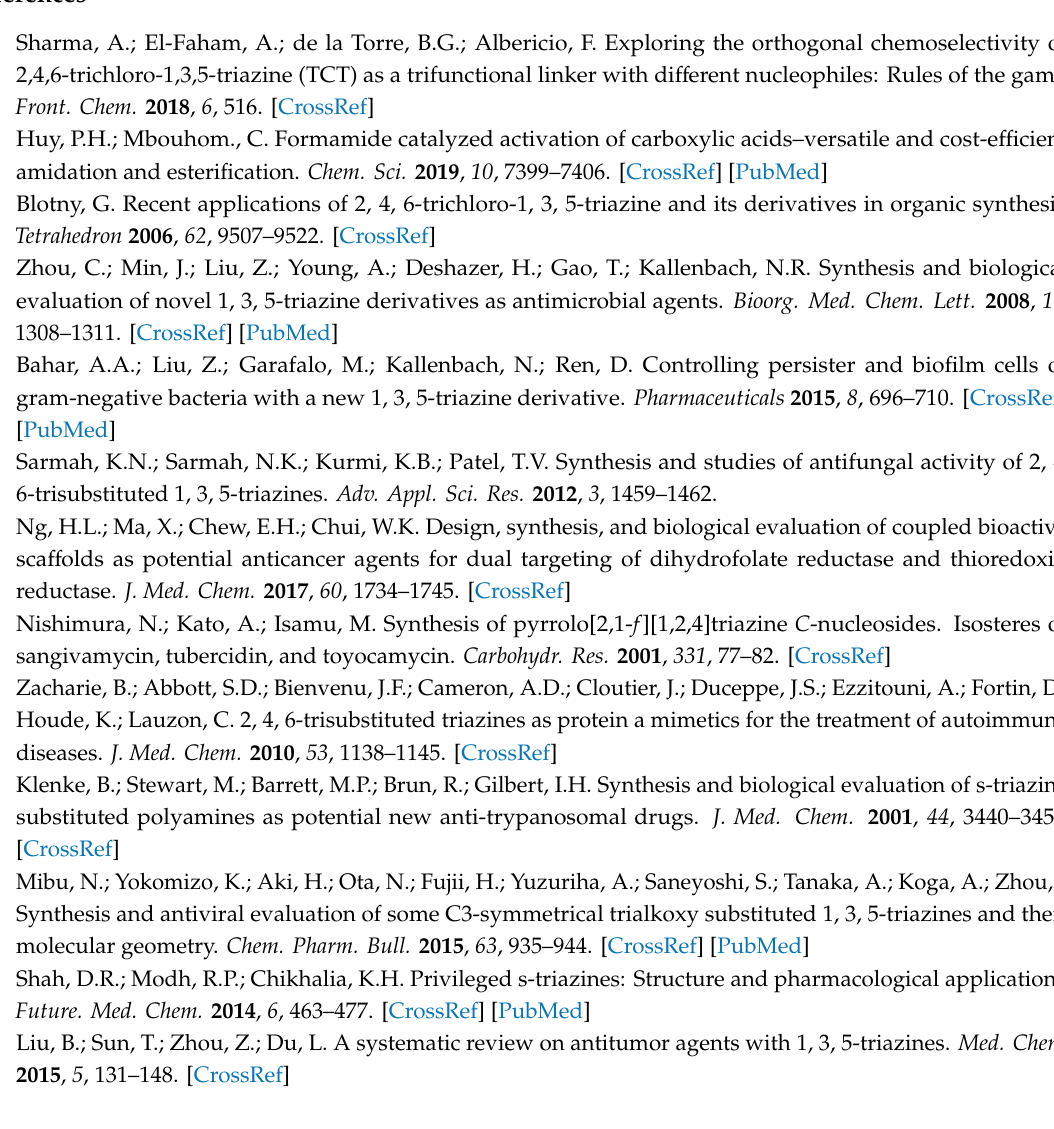
Figure S2: 1H-NMR and 13C-NMR for compound 7b, Figure S3: 1H-NMR and 13C-NMR for compound 7c, Figure S4: 1H-NMR and 13C-NMR for compound 7d, Figure S5: 1H-NMR and 13C-NMR for compound 7e, Figure S6: 1H-NMR and 13C-NMR for compound 7f, Figure S7: 1H-NMR and 13C-NMR for compound 8e, Figure S8: 1H-NMR and 13C-NMR for compound 9a, Figure S9: 1H-NMR and 13C-NMR for compound 9b, Figure S10: 1H-NMR and 13C-NMR for compound 9c, Figure S11: 1H-NMR and 13C-NMR for compound 9d, Figure S12: 1H-NMR and 13C-NMR for compound 9e, Figure S13: 1H-NMR and 13C-NMR for compound 9f, Figure S14: 1H-NMR and 13C-NMR for compound 10, Figure S15: 1H-NMR and 13C-NMR for compound 11, Figure S16: 1H-NMR and 13 C-NMR for compound